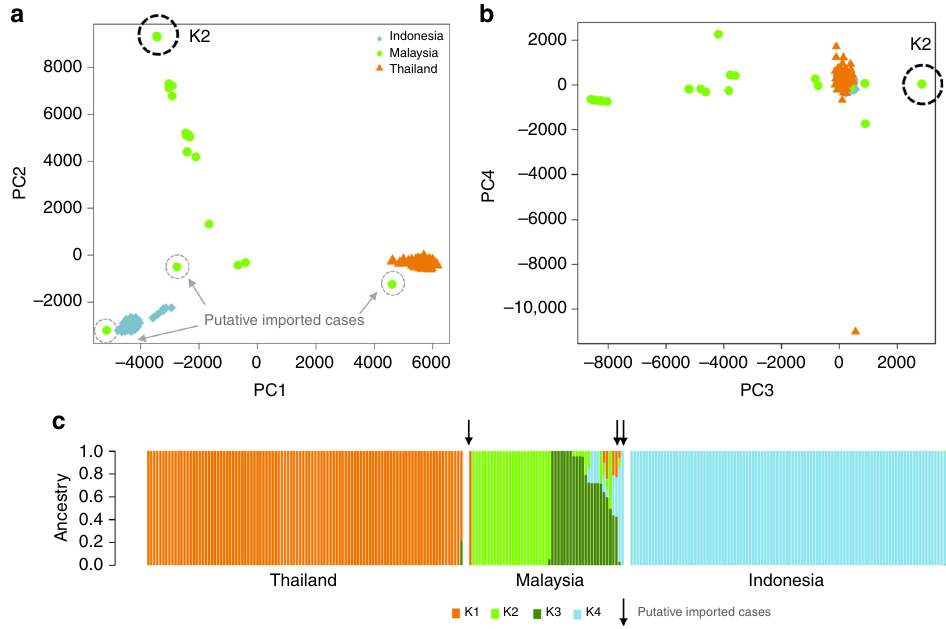
Fig. 2 Plasmodium vivax population structure in Sabah relative to Thailand and Indonesia. a , b PCoA plots illustrating the genetic differentiation within and between populations. Principal components 1 – 4 re fl ect 17.6%, 11.7%, 3% and 1.3% of the variance, respectively. The genetically identical Malaysian K2 isolates are circled in black and the three putatively imported infections are circled in grey; the unlabelled green dots re fl ect the K3 and mixed ancestry infections which constitute the baseline Sabah population. Aside from the K2 strain, there is clear evidence of divergence among the baseline Sabah isolates. c An ADMIXTURE bar plot illustrating the population structure within and among populations at K = 4, highlighting the clear distinction between Thailand, Malaysia and Indonesia, and the marked sub-structure within Malaysia. All plots were generated using genomic data derived from 259 high- quality